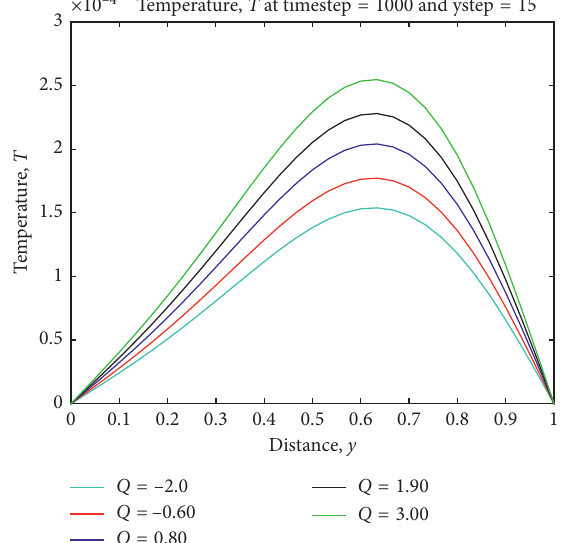
Figure 8: Graph of effects of heat source/sink parameter on temperature profile T .